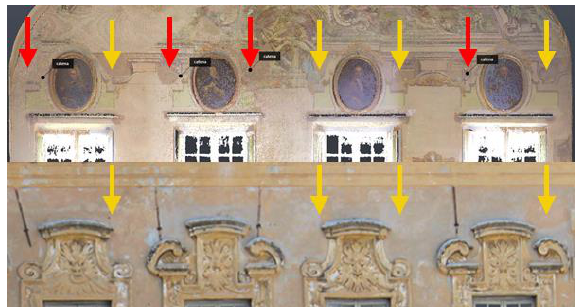
Figure 9. visualization in reflectance scale (custom colours) - 3d model of the vault elaborated with laser scanning